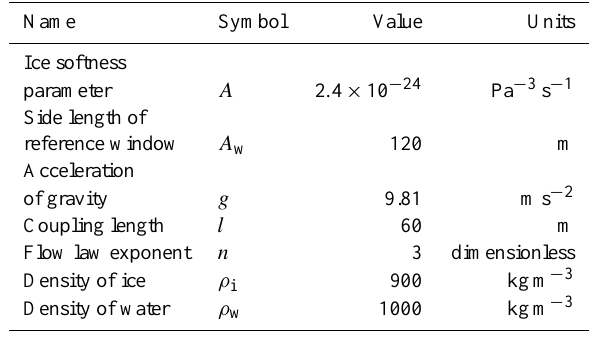
Table 3. Constants used in modeling